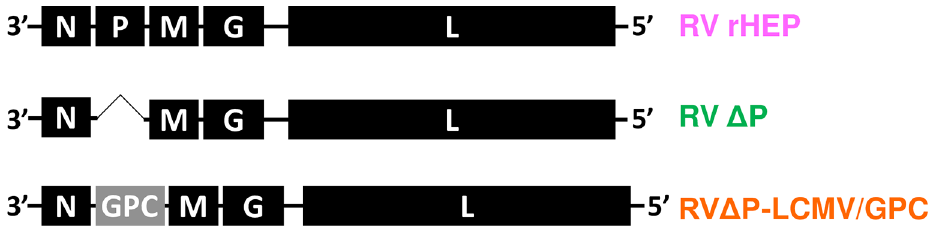
Fig 1. Schematic diagrams of the recombinant RVs genome constructs. Recombinant HEP-Flury (rHEP) has a complete genome of RV HEP-Flury strain (upper), RV Δ P lacks the RV-P gene (middle). RV Δ P-LCMV/GPC harbors the LCMV-GPC gene after the RV-N gene of the